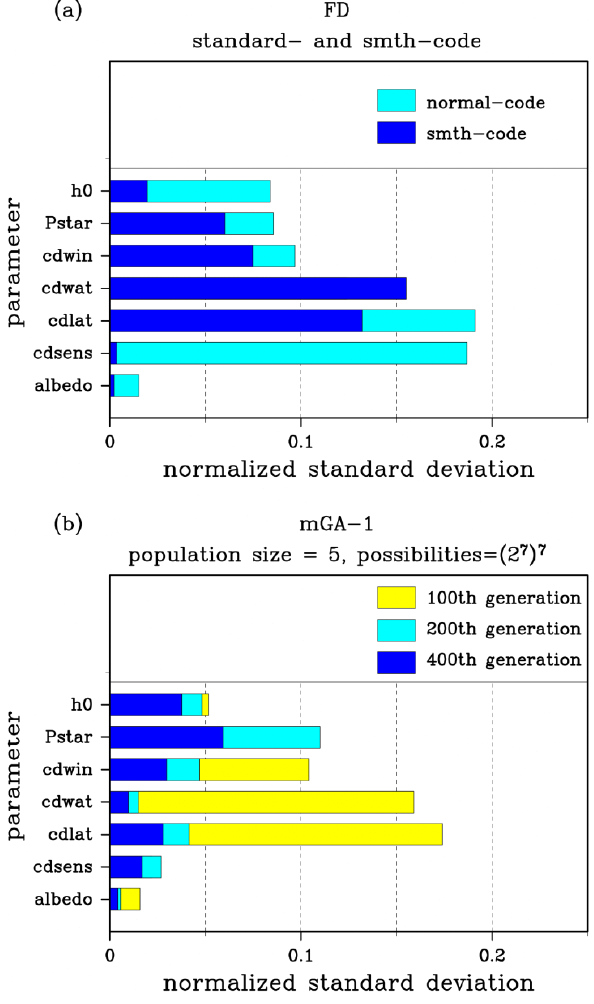
Fig. 15. Standard deviations of the estimated parameters obtained from 10 independent optimization experiments by (a) the FD method and (b) µGA. The standard deviations were normalized by corresponding parameter ranges: the nor- malized standard deviation of i -th parameter is given by " # 1 2 L (cid:16) (cid:17) − 1 P − m min m max L − 1 ( ¯ m i − m i ) 2 , where L is the num- i i l = 1 ber of optimization experiments and ¯ m i is a mean of estimated i -th